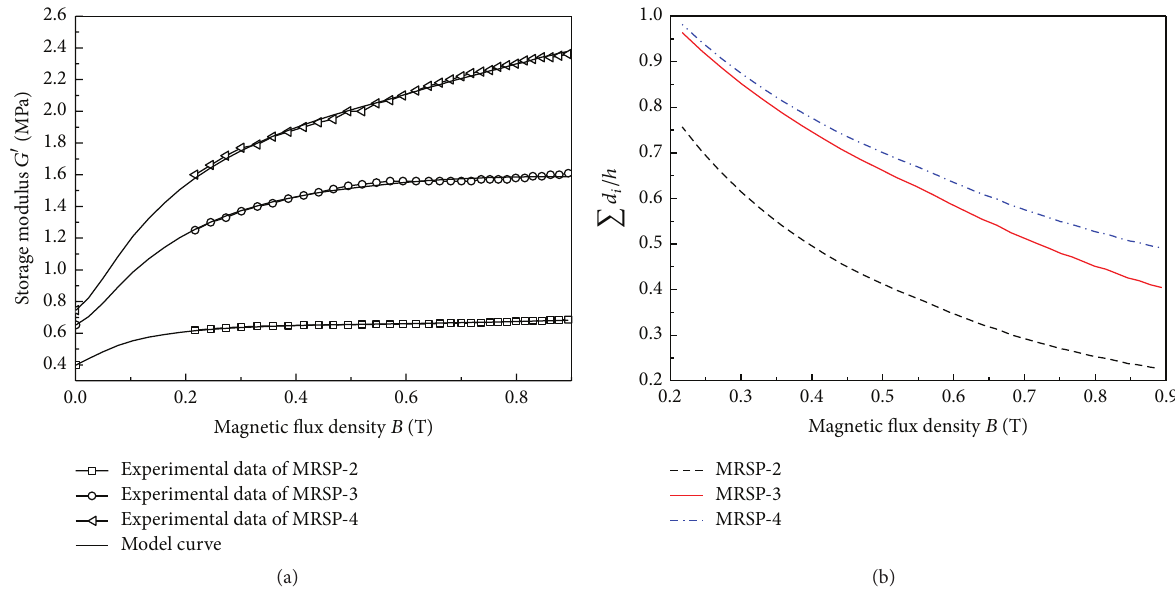
Figure 11: (a) 𝐺 󸀠 - 𝐵 curves of MRSPs based on the nonperforative particle aggregated chains model. (b) The trend of variable ∑ 𝑑 𝑖 /ℎ with magnetic flux density 𝐵